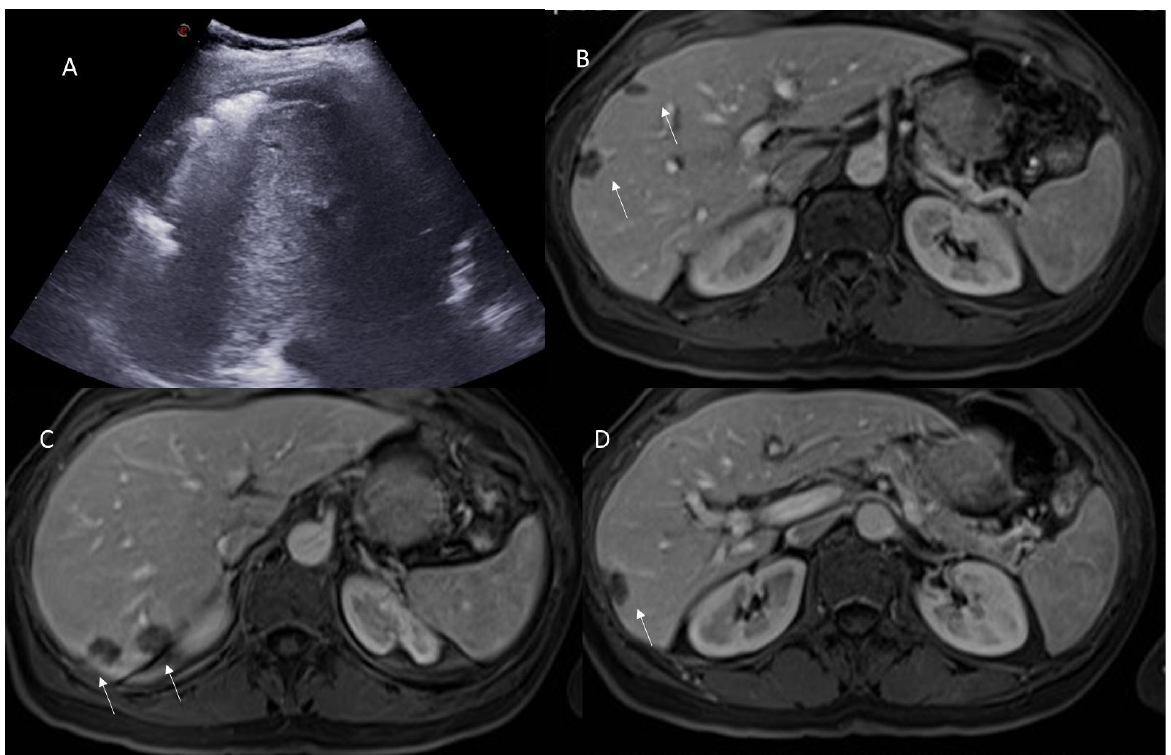
Figure 4. US ( A ) assessment and CT ( B – D ) assessment of Figure 3, patient. On portal phase of con- trast medium evaluation, arrows (( B ): V seg; ( C ): VII seg and ( D ): VI seg) show typical fluid collection due to surgical procedure.